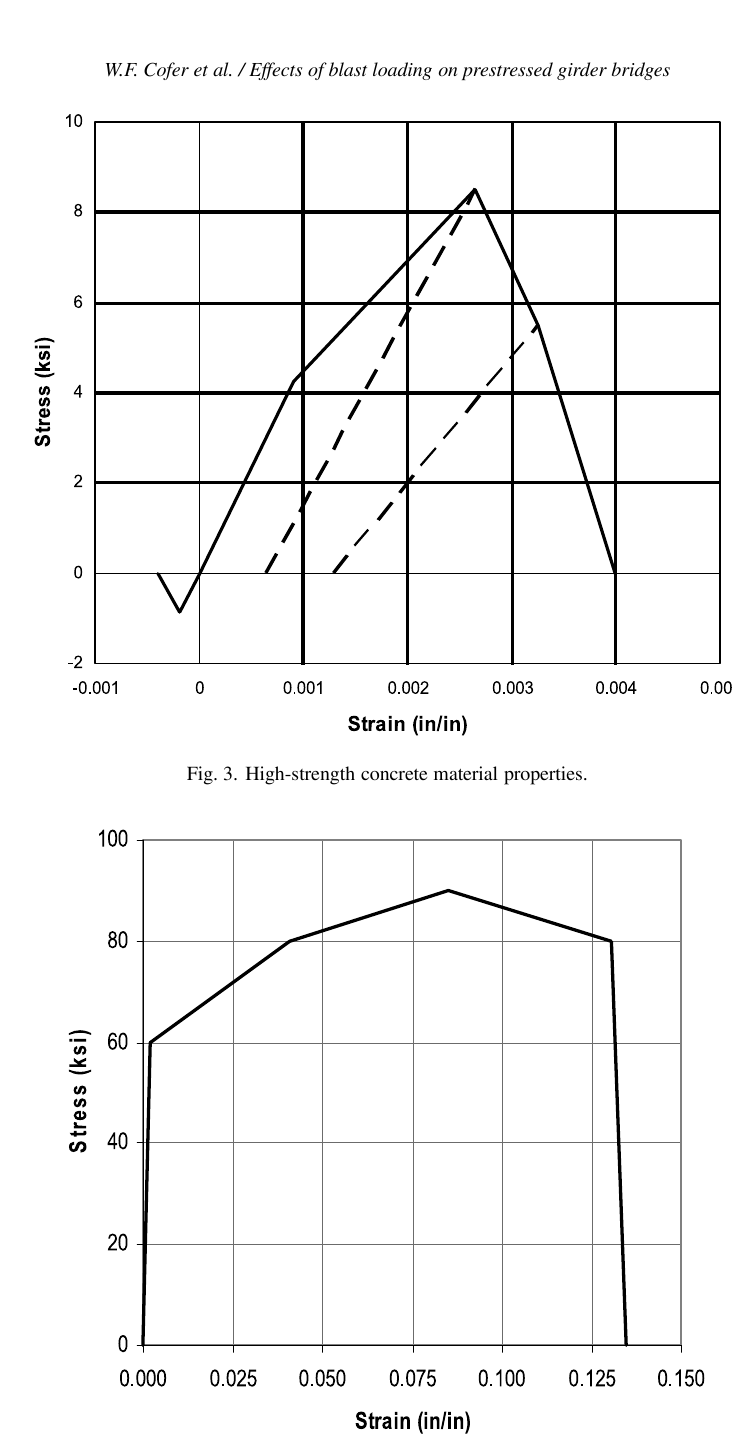
Fig. 4. Mild Reinforcing Steel Material